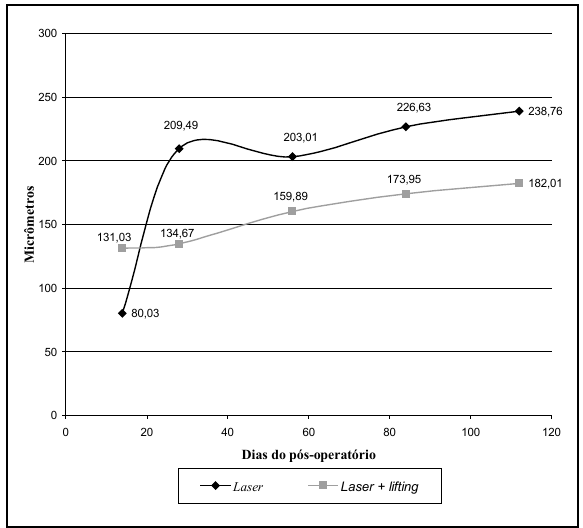
Figura 1 – Compara a espessura da fibroplasia em micrômetros (eixo Y) nos grupos EI ( laser ) e EII ( laser + lifting ) nos dias 14, 28, 56, 84 e 112 do pós-operatório (eixo X)